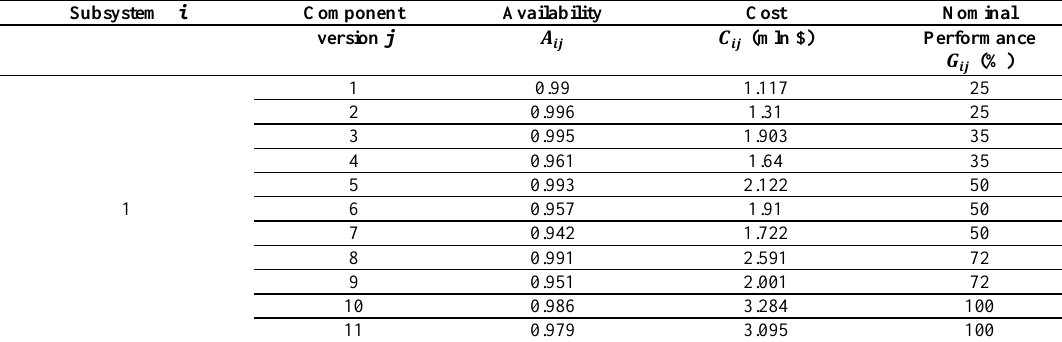
Table 11. Data of the components available in the market (Example